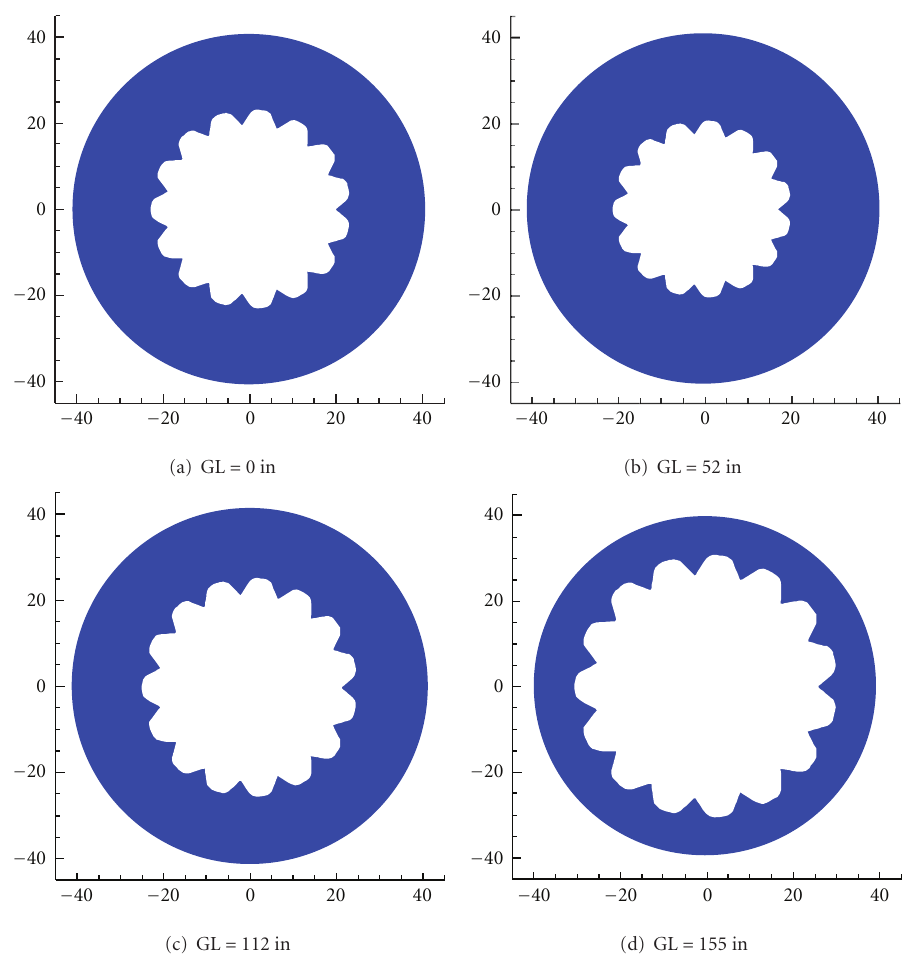
Figure 11: Optimized grain cross section for regressive-progressive-regressive profile allowing outer-mold line to